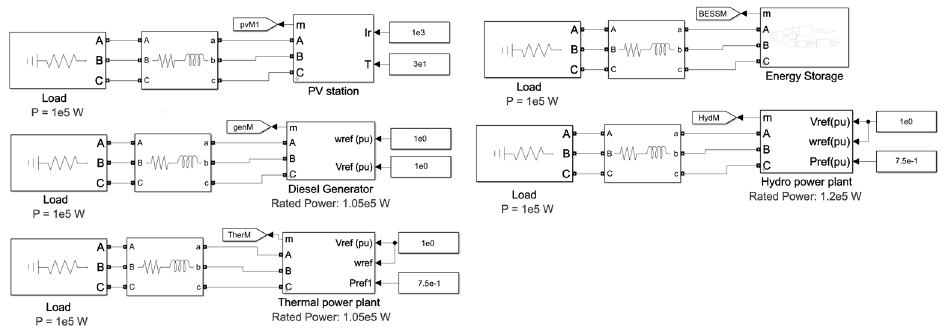
Figure 13. Modeled scheme of Simulink.